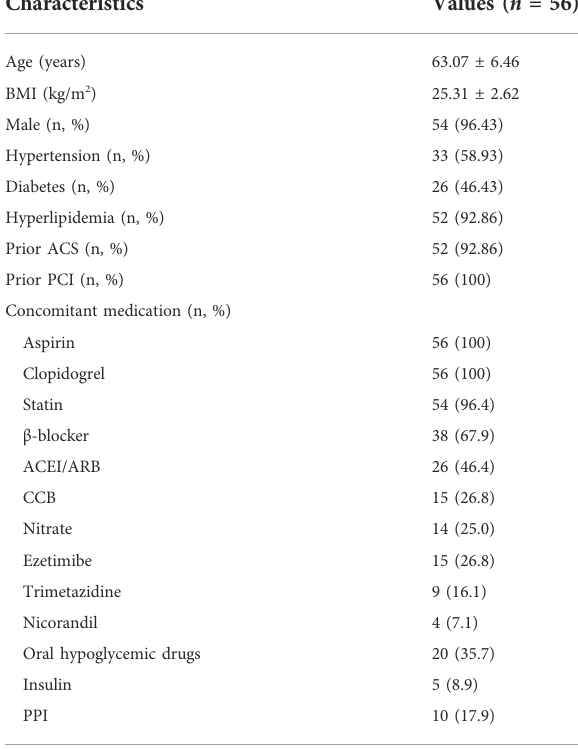
TABLE 1 Patient demographics and clinical